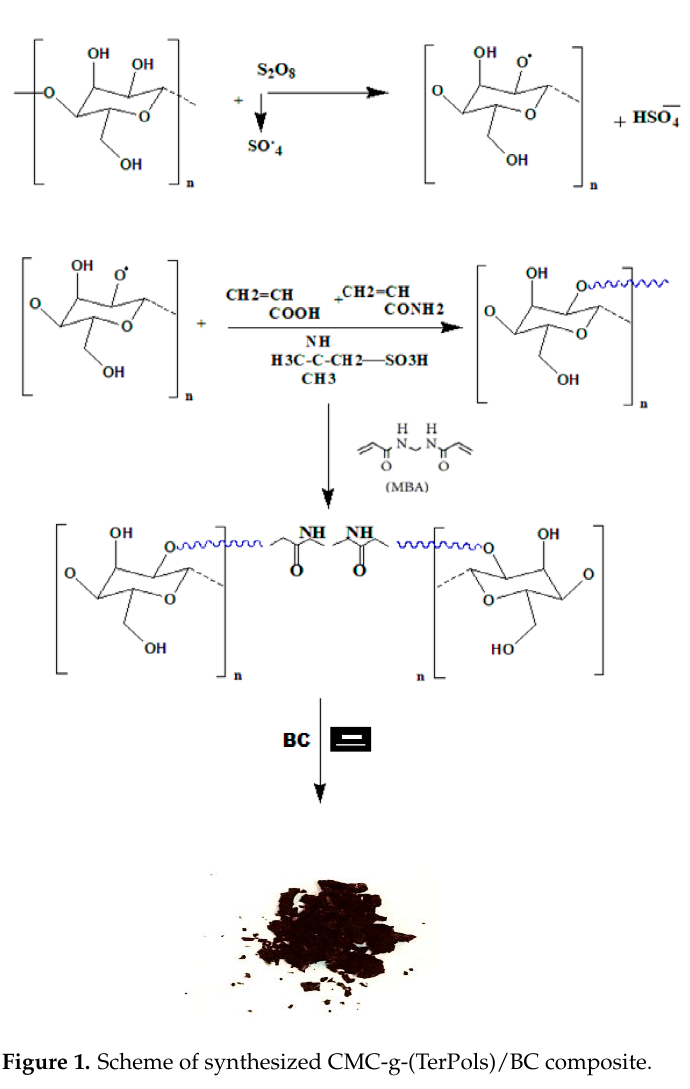
Figure 1. Scheme of synthesized CMC-g-(TerPols)/BC composite.